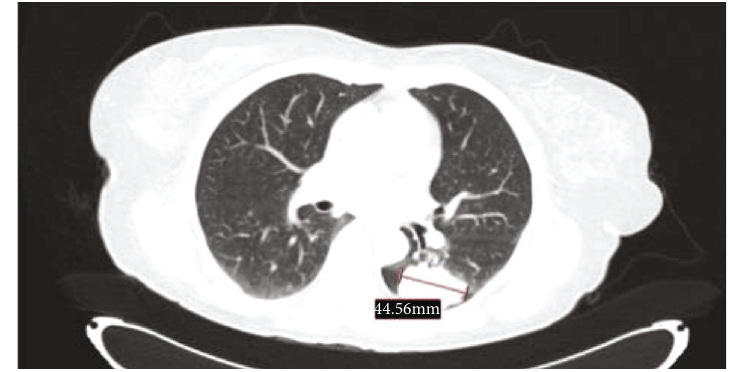
Figure 2: Lung mass on thoracic CT scan at